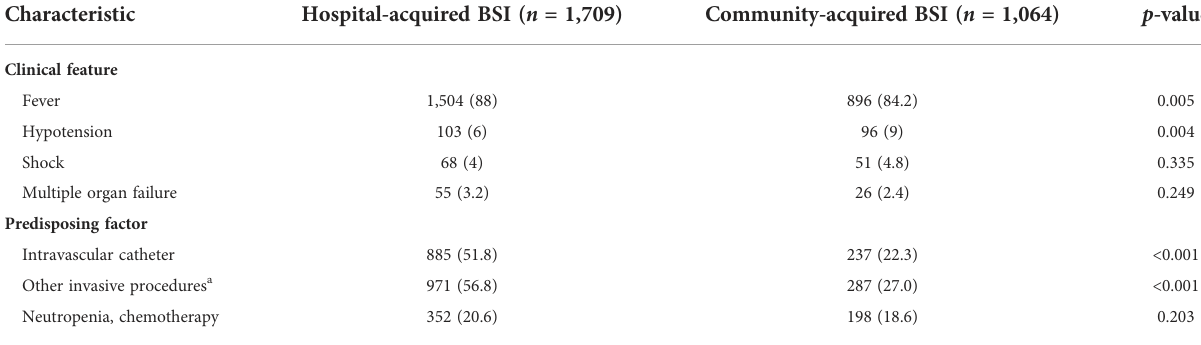
TABLE 2 Clinical features and predisposing factors compared between hospital- and community-acquired bloodstream infections.